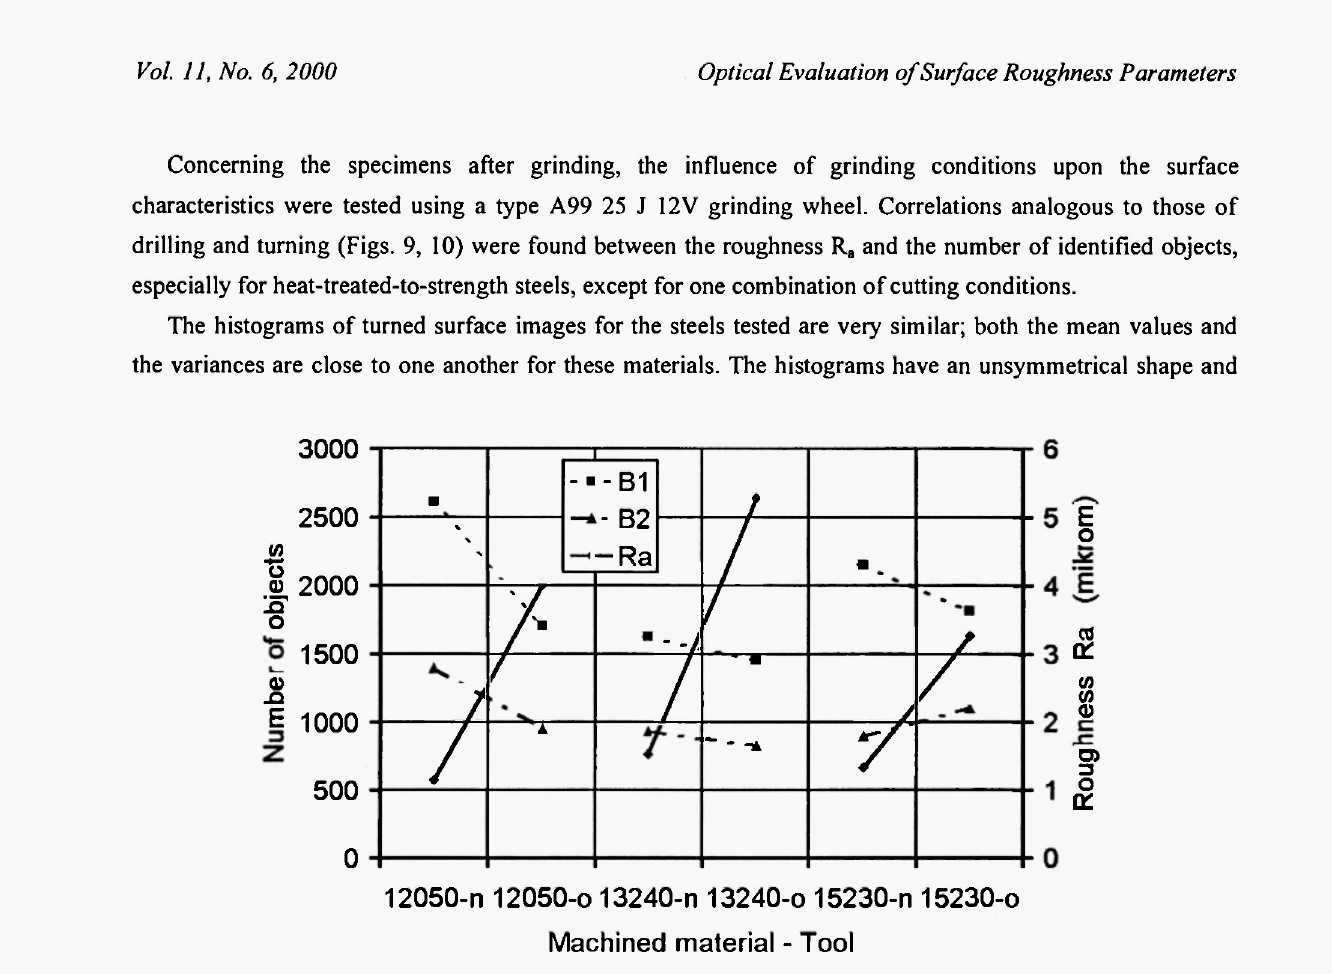
Fig. 9: Influence of tool wear upon number of objects with turning (n - sharp tool, - worn-out tool).